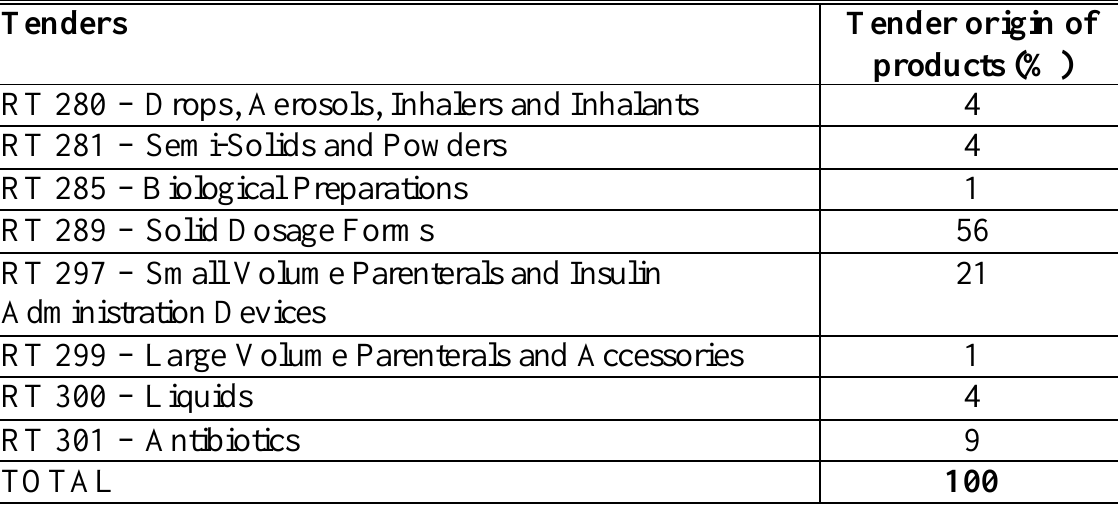
Composition of public sector price comparison